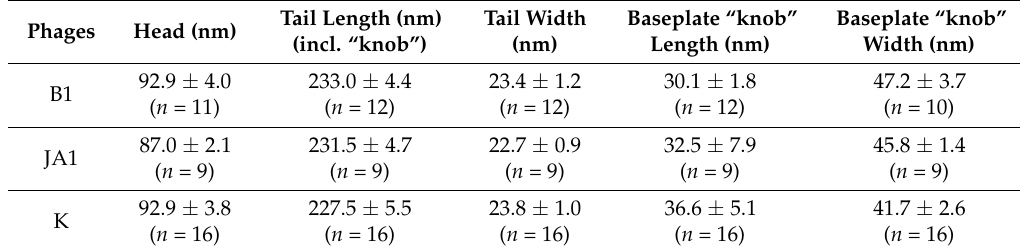
Table 1. Dimensions of staphylococcal phages B1, JA1, and K derived from micrographs obtained from transmission electron microscopy.